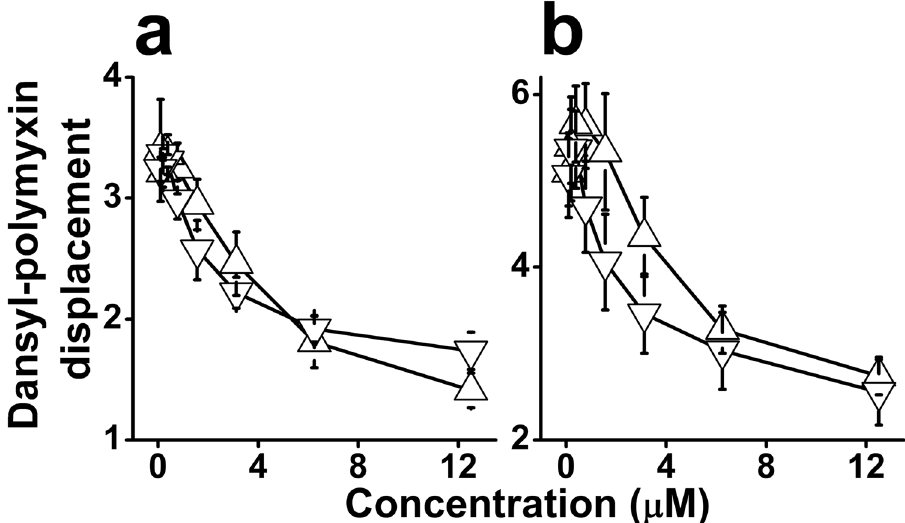
Figure 3. Dansyl-polymyxin binding assay. Interaction with LPS was assessed by incubation (1.5 hr) of C 14 KKc 12 K and polymyxin B with 2 μ M pure monodansyl-polymyxin and 3 μ g/ml LPS from E. coli ( a ) or P. aeruginosa ( b ). Symbols: triangles, C 14 KKc 12 K; inverted triangles, Polymyxin B; The Y axis represents fluorescence measurements (excitation: 340 nm, emission: 485 nm). Results are from two independent experiments performed in duplicate. Error bars represent the standard deviation.